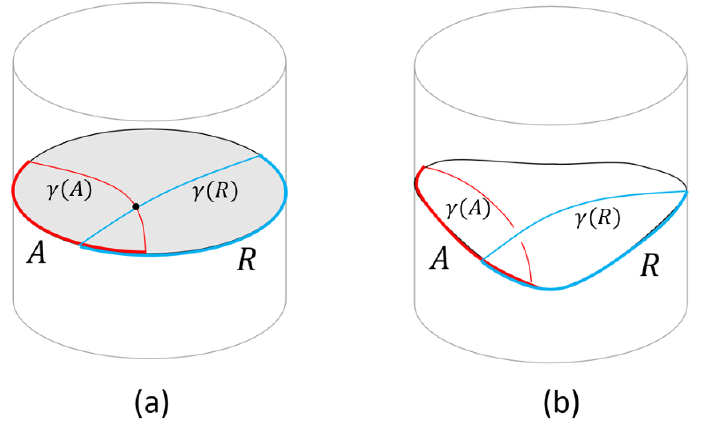
Figure 1. Illustration of HRT surfaces for di(cid:11)erent boundary regions. (a) For a state with time re(cid:13)ection symmetry, all HRT surfaces of di(cid:11)erent boundary regions lie in the same bulk slice, so that HRT surfaces of boundary overlapping regions must intersect. (b) For a generic boundary state de(cid:12)ned by a boundary Cauchy slice, the HRT surfaces of two overlapping regions R and A generically cannot be included in any bulk Cauchy slice, if they are time-like